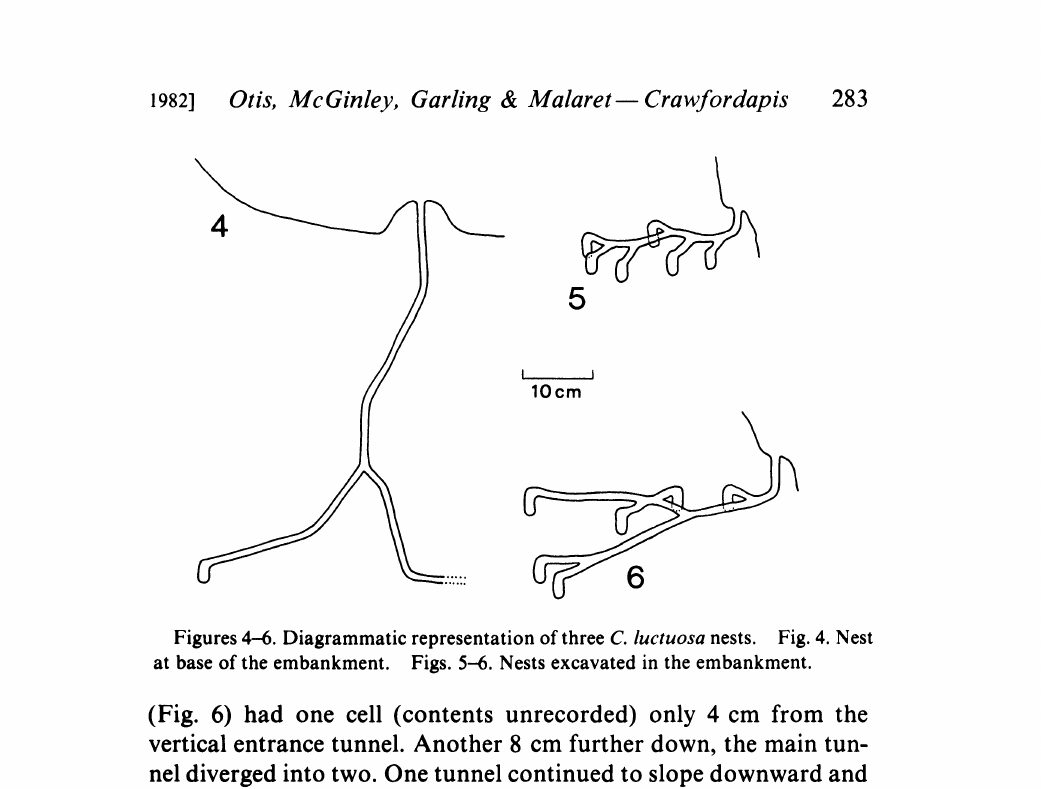
Figures 4-6. Diagrammatic representation of three C. luctuosa nests. Fig. 4. Nest at base of the embankment. Figs. 5-6. Nests excavated in the